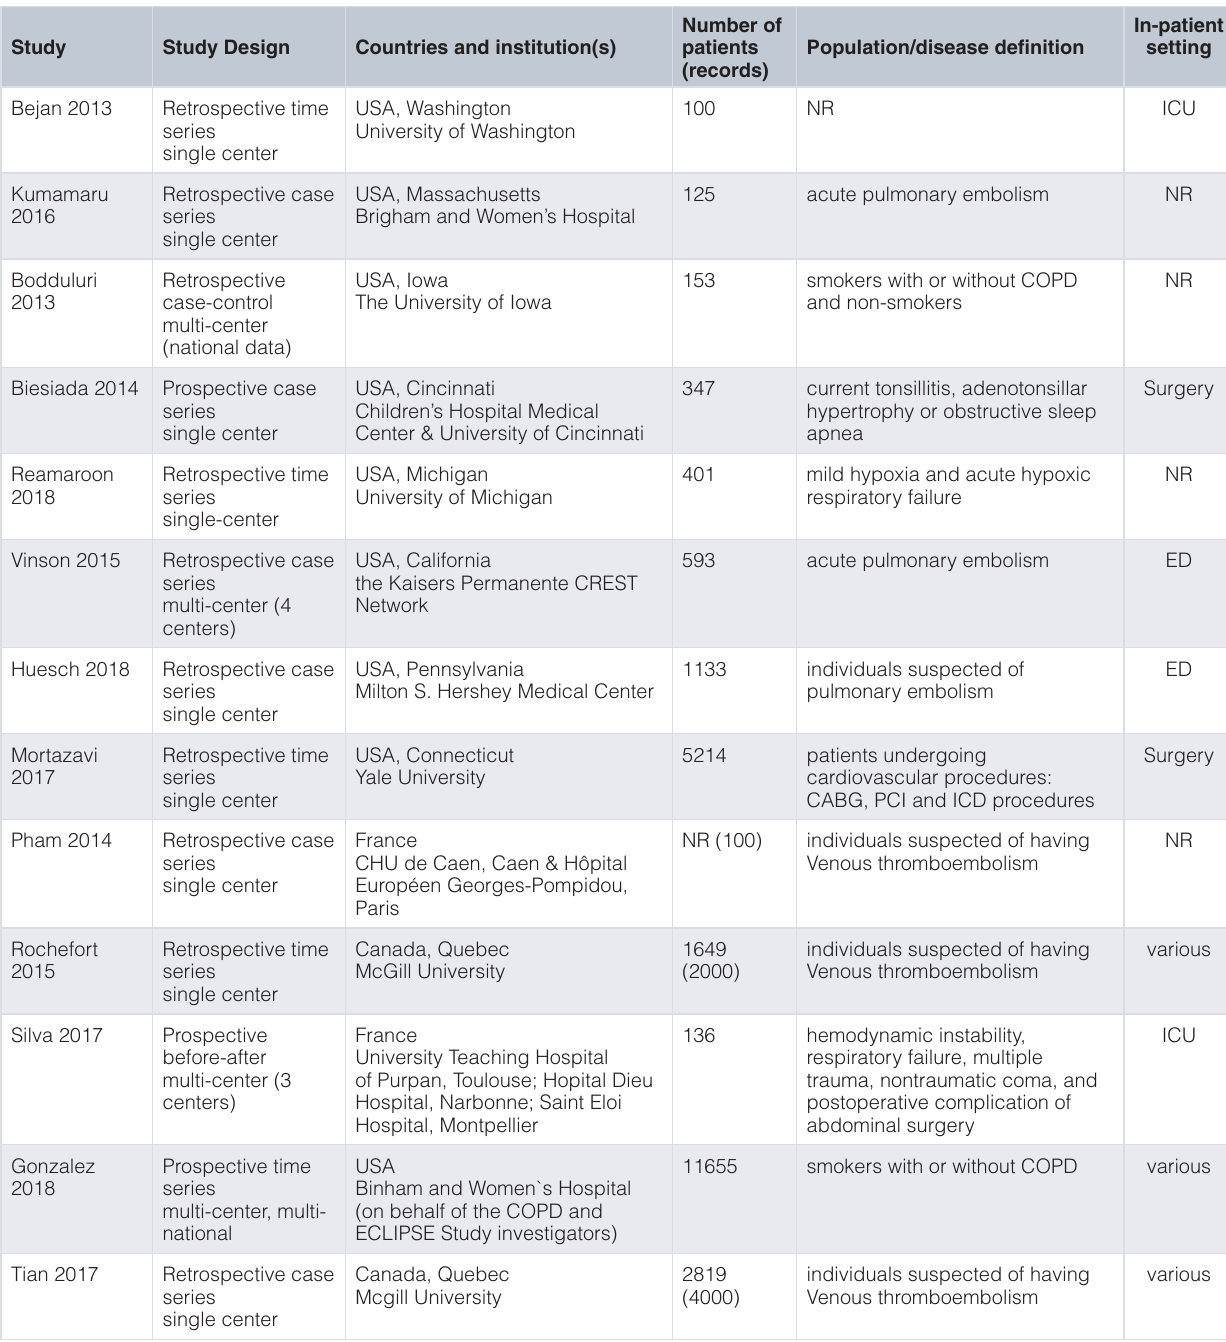
Table 6. Design aspects of published studies on respiratory distress or failure.